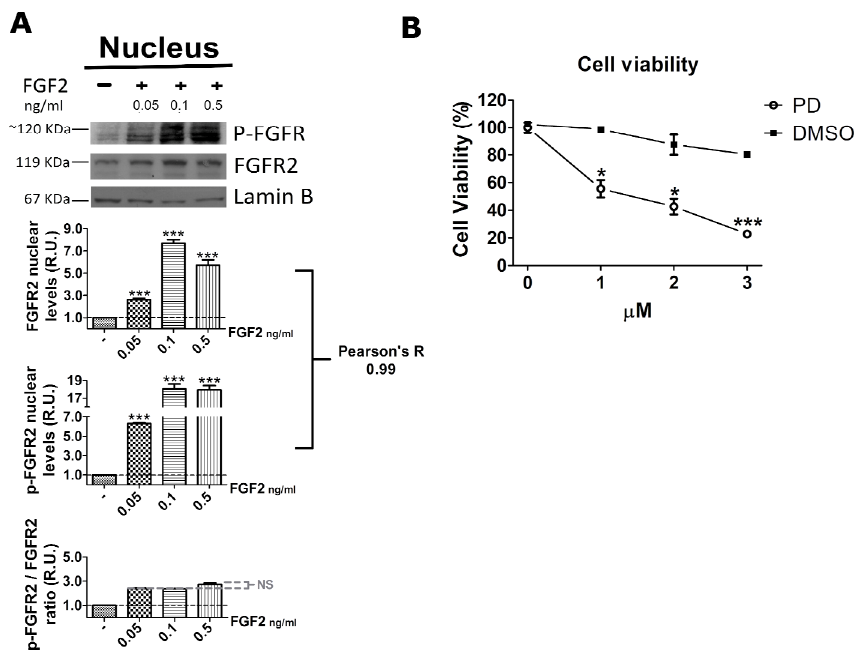
Figure 4. FGF2 promotes FGFR2 activation and nuclear translocation. ( A ) Western blot analysis of nuclear extracts obtained from serum-deprived RS4;11 cells stimulated with increasing concentrations of FGF2 performed with an anti-phospho-FGFR2 (p-FGFR2) or an anti-FGFR2 (FGFR2) antibody; lamin B was the control for protein loading; densitometric analysis of band intensity is graphically shown for FGFR2, p-FGFR2, and p-FGFR2/FGFR2 ratio. ( B ) Cell viability assay performed following treatment of RS4;11 cells with the FGFR inhibitor PD173074 (PD) and the vehicle (DMSO). Statistical significance was calculated by one-way two tail paired t -test. p -values are indicated as follows: * = p < 0.05, *** = p < 0.005. Pearson’s R = 0.99 is consistent with a positive correlation between the two set of values. NS, not significant. R.U., relative units.